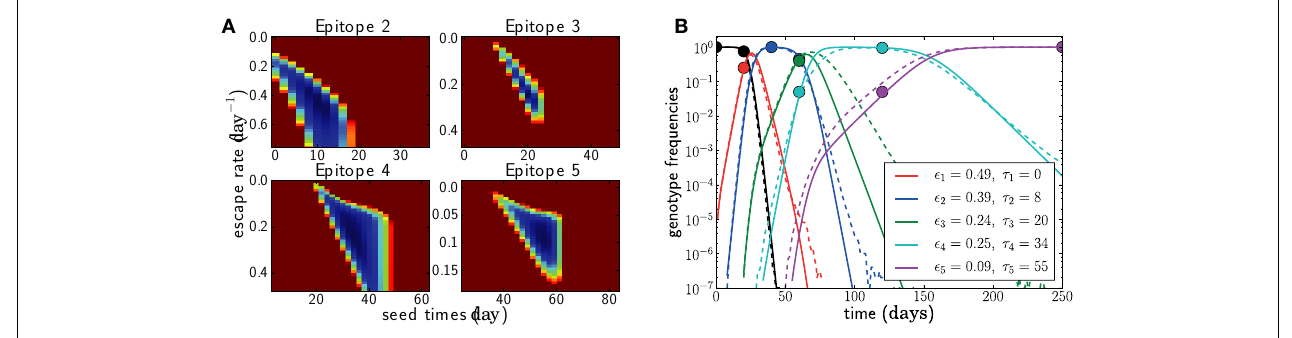
of the founder virus and the dominant escape variants (solid lines: model fit, dashed lines: actual simulated trajectories).The estimated escape rates of individual epitopes and the seed times of genotypes containing all escape mutations up to j are given in the legend. Only the samples indicated by balls (20 sequences at each time point) were used for the estimation. In this run, N = 10 7 , µ = 10 − 5 , r = 0, and the escape rates